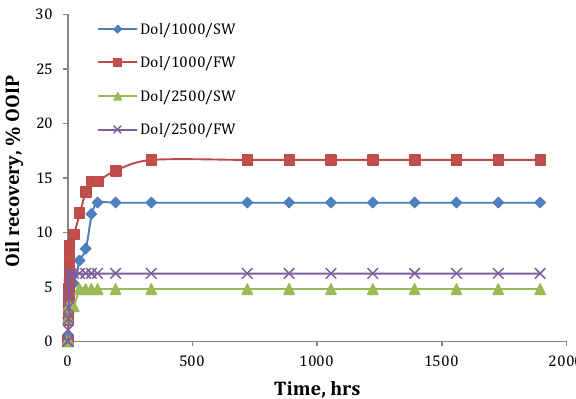
Fig. 5 Oil recovery from dolomite samples aged 1000 and 2500